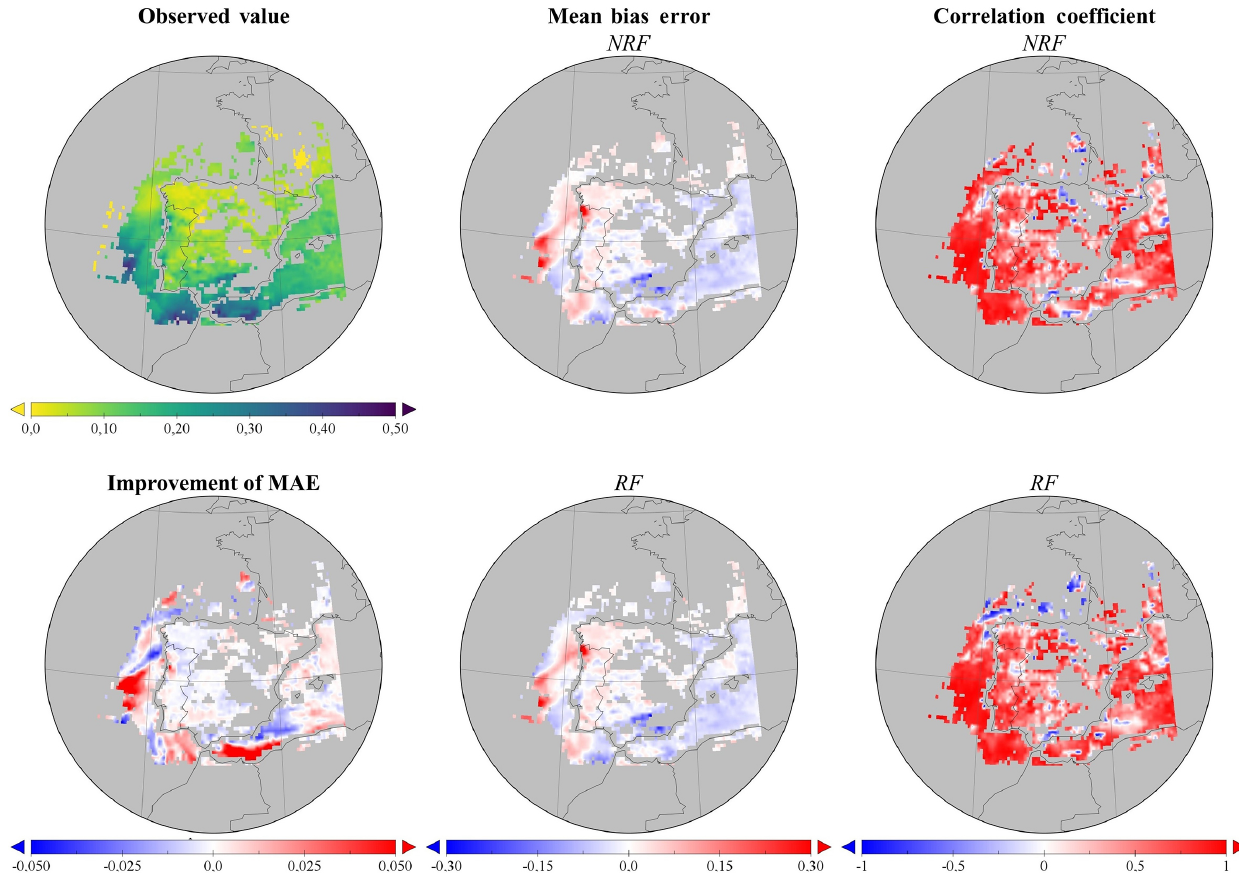
Figure 5. As Fig. 4 but for the fire episode (temporal mean from 25 July to 7